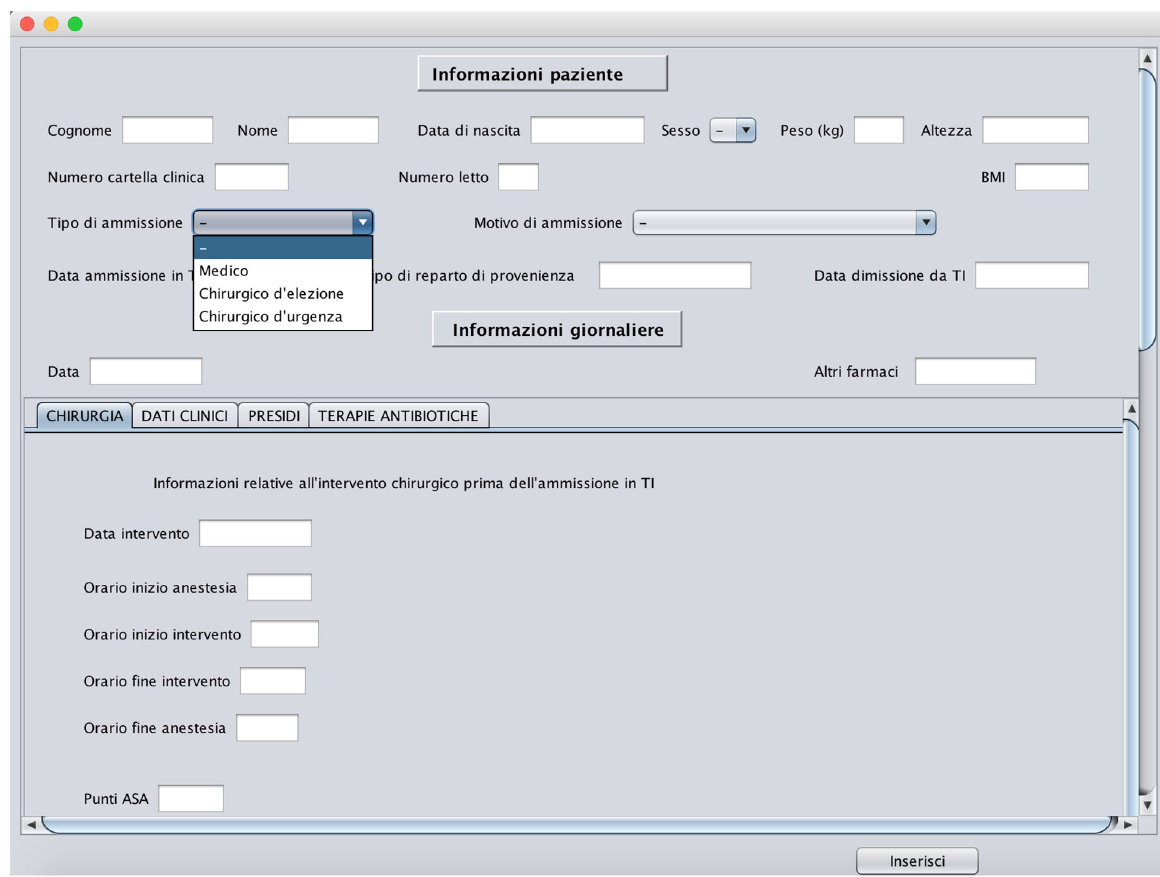
Fig 12. General information on patients and panels for specific